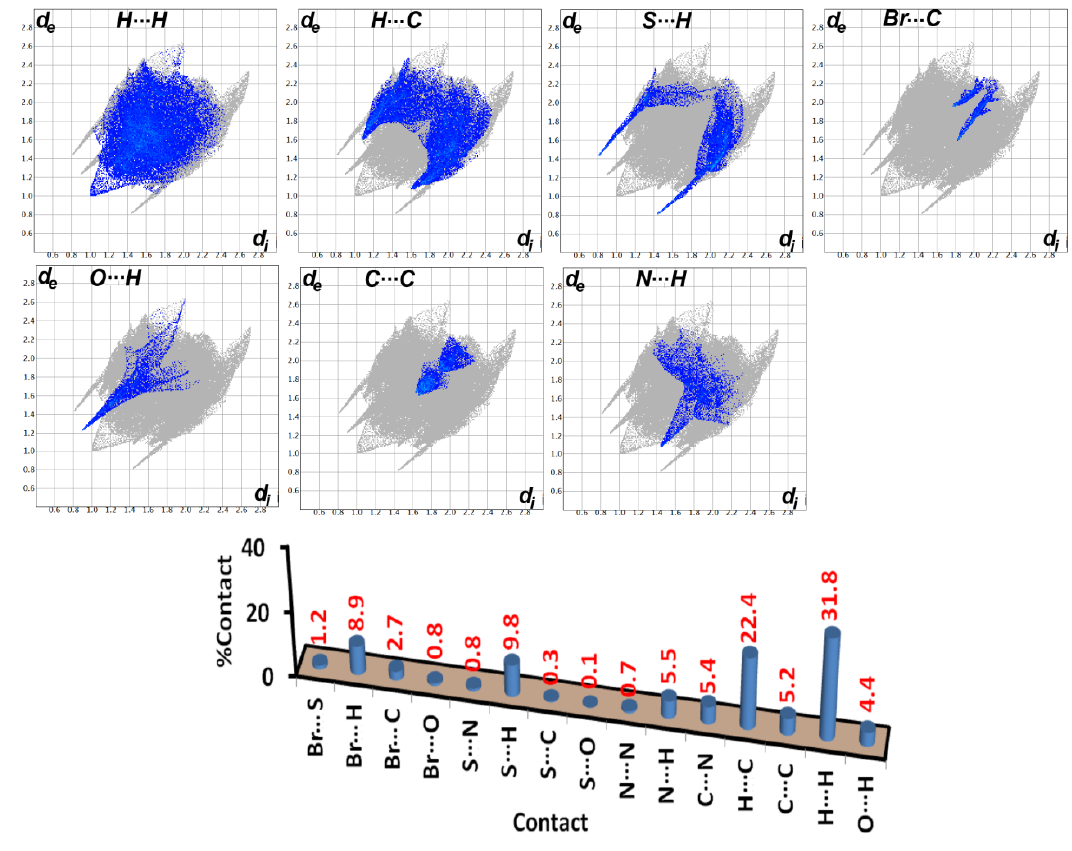
Figure 5. Decomposed fingerprint plots of the most dominant contacts and the percentages of all possible intermolecular interactions in the crystal structure of 3 .